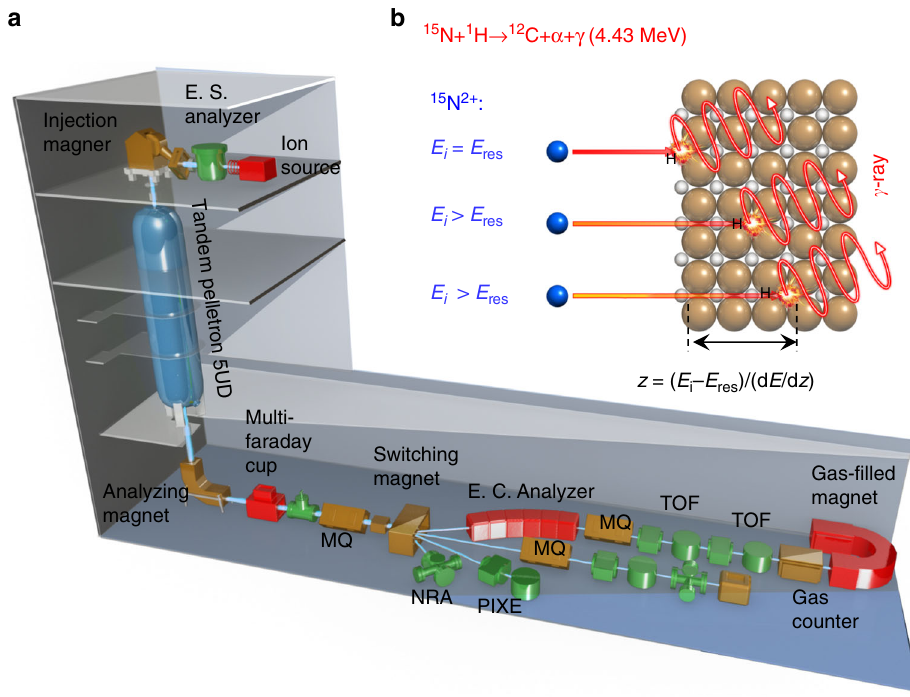
Fig. 1 Illustration of the nuclear reaction analysis. a Schematic illustration of the accelerator system for the nuclear reaction analysis (NRA). The system consists of components, such as the ion source, electrostatic spherical (E.S.) analyzer, injection magnet, electrostatic cylindrical (E.C.) analyzer, several magnetic quadrupole-lens (M.Q.), time of fl ight (TOF), and analyzing cambers. In the present work, the system is mainly used for the NRA measurement, while the ultra high vacuum NRA, Rutherford backscattering (RBS), elastic recoil detection analysis (ERDA), and particle induced X-ray emission (PIXE) can be also performed in additional chambers and altering the ion source. b The working principle for quantitative detection of the hydrogen composition as a function of distribution depth by using nuclear reaction analysis (NRA). Only 15 N 2 + ions with kinetic energies ( E K ) of 6.385 MeV after penetrating SmNiO 3 (Energy loss: 3.1945 keV nm − 1 ) can be resonant with the hydrogen element and yield detectable